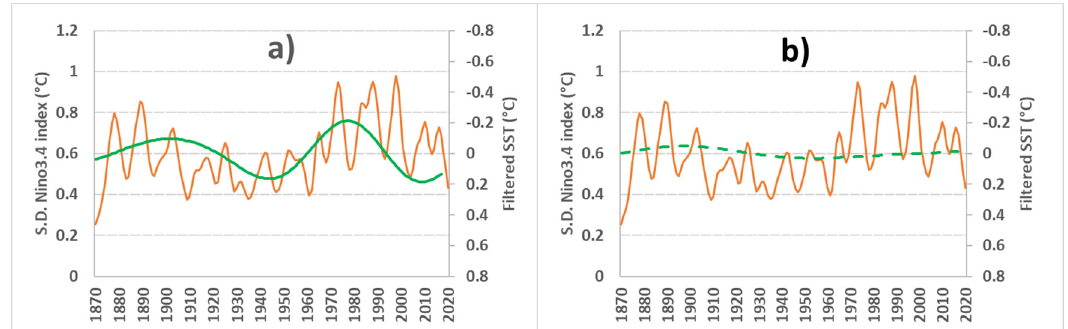
Figure 9. Standard deviation of the Nino3.4 index in the 1.5–7 years band (in red) and estimation of the filtered global temperature from the linear combination of SST anomalies 0.75 × NA + 0.25 × NP located [36 ◦ N, 39 ◦ N] × [30 ◦ W, 40 ◦ W] in the North Atlantic (NA), and [30 ◦ N, 33 ◦ N] × [170 ◦ E, 180 ◦ E] in the North Pacific (NP) subtropical gyres (in green)—( a ) SST anomalies filtered in the 48–96 years band—( b ) SST anomalies filtered in the 96–150 years band.